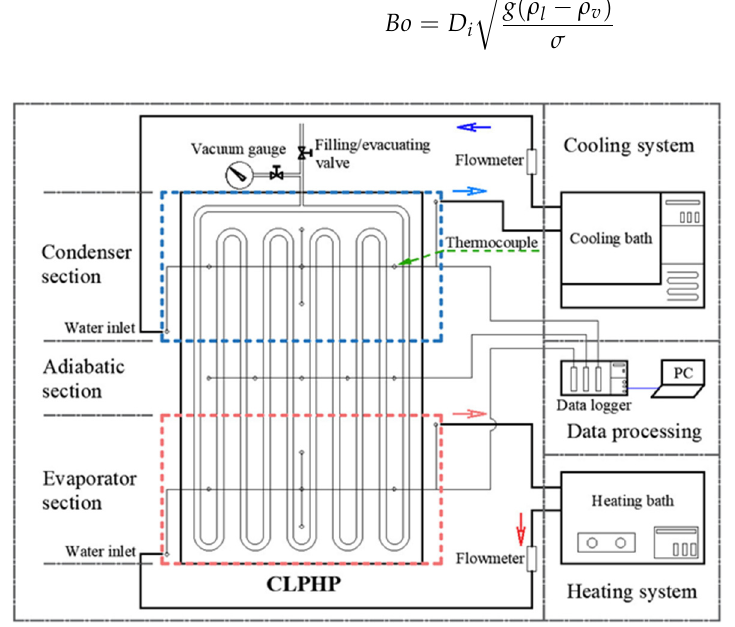
Figure 1. Schematic of experimental